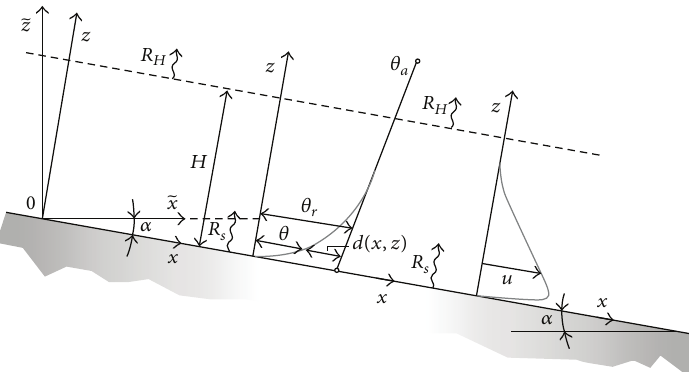
Figure 19: Schematic of the model proposed by Manins and Sawford [6] for the investigation of katabatic currents.